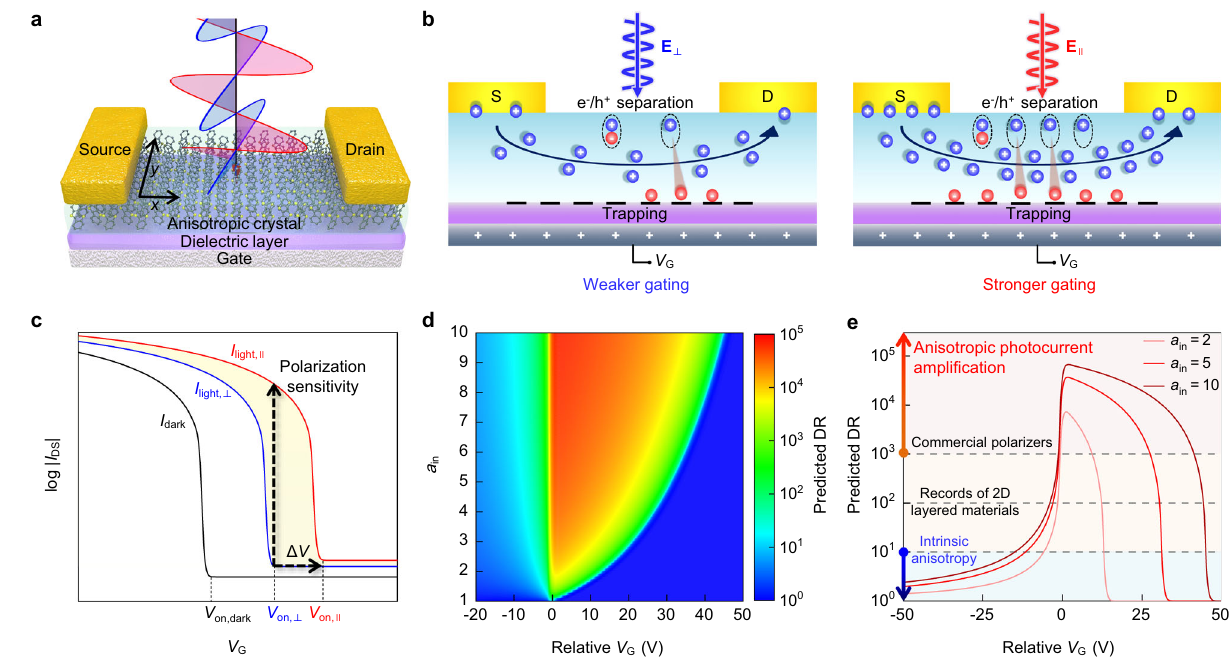
Fig. 1 | Anisotropic charge trapping effect for polarization sensitivity enhancement in phototransistors.a Schematic illustration ofa bottom-gate top- contact phototransistor based on an anisotropic photoactive crystal. b Schematic illustrations of the anisotropicchargetrapping effect. Anisotropiclight absorption results in the polarization-dependent trapping of photogenerated charge carriers. Thesetrappedcarriersinduceananisotropicphoto-inducegatebiastoamplifythe channel current to different extent. c Schematic illustration of the transfer